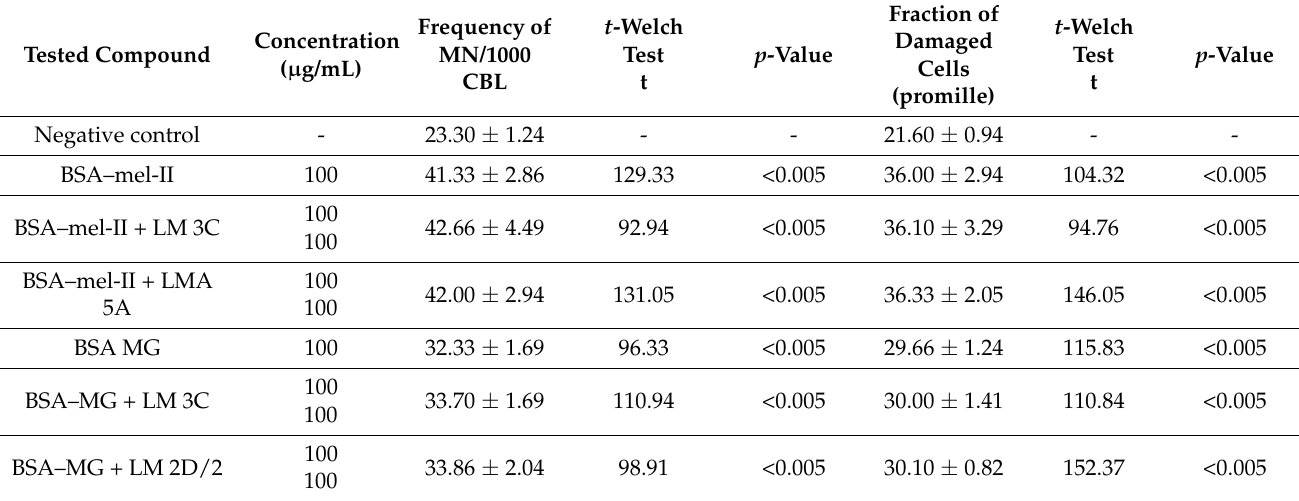
Table 2. Damage of human PBLs DNA in the presence of equivalent concentrations of HMW– and LMW–MAGE in the cell